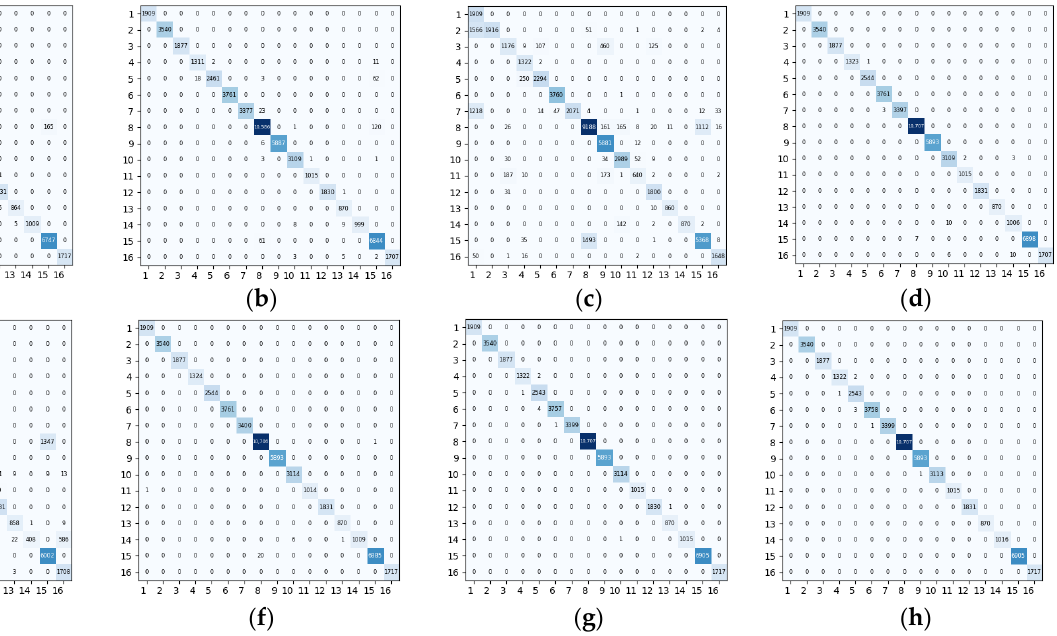
Figure 13. Confusion matrix of different methods for the Salinas Scene data set. ( a ) Baseline ( b ) 3DCNN ( c ) SSRN ( d ) HybridSN ( e ) ViT ( f ) 3D_Octave ( g ) OctaveVit ( h ) SATNet.